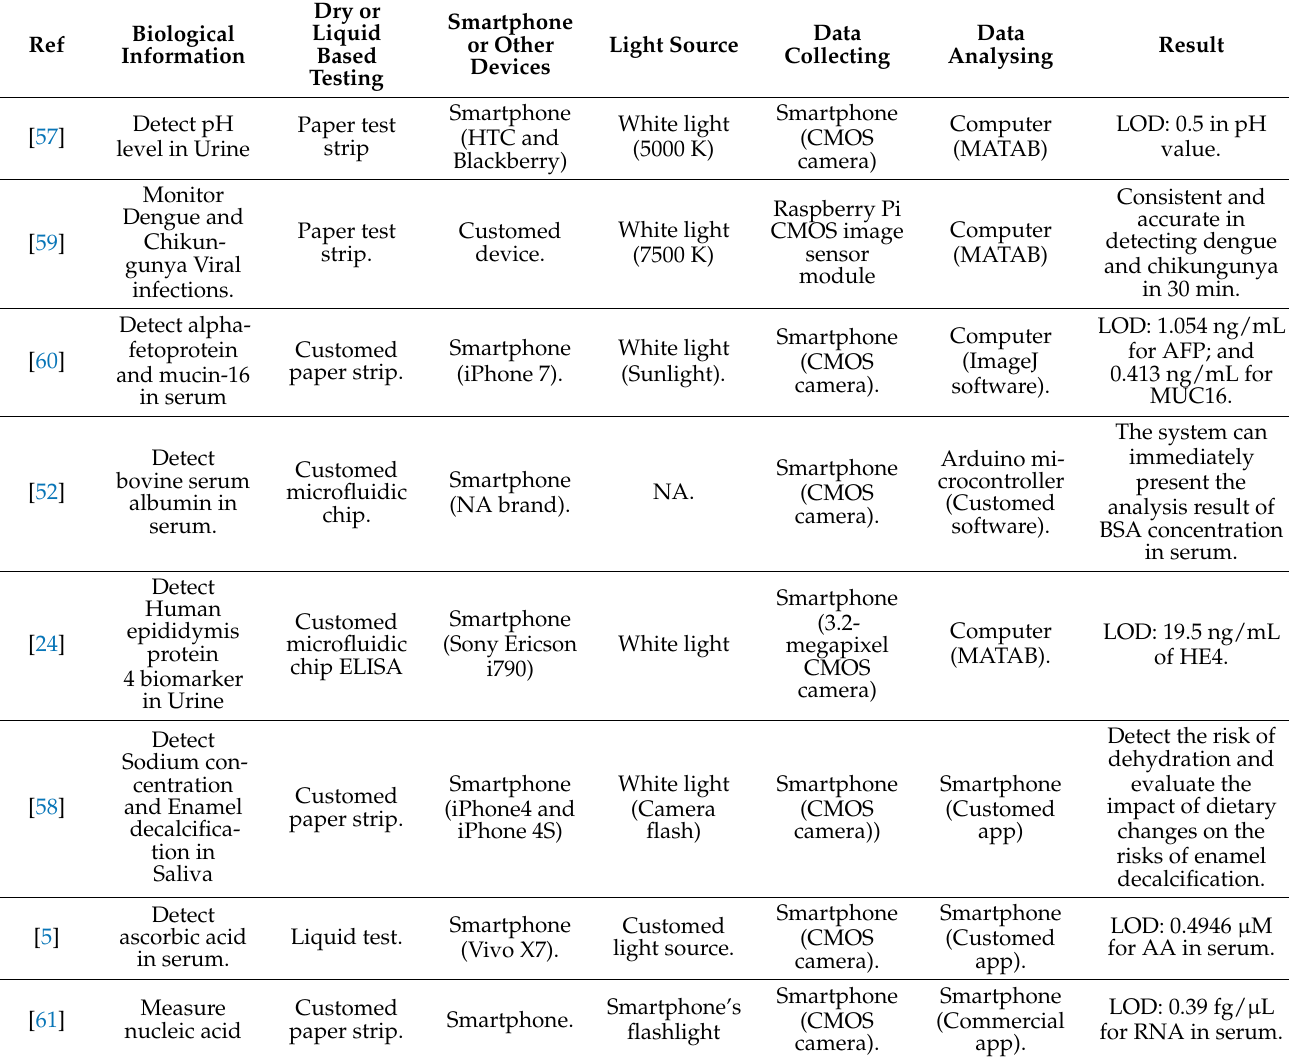
Table 2. Portable devices using the colorimetric method to detect biomarkers in body